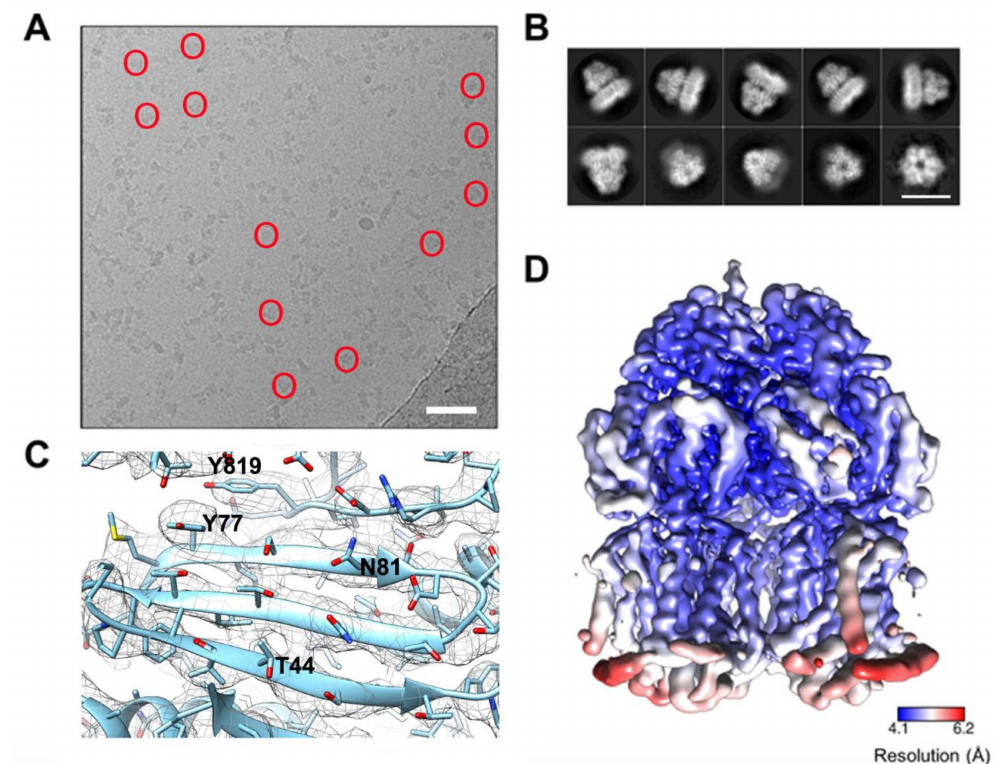
Figure 1. Single particle cryo-electron microscopy reconstruction of STmAcrB G288D processed in C3 space group. ( A ) Representative micrograph of S TmAcrB G288D collected on a K2 camera, with a scale bar in white representing 50 nm. Some representative STmAcrB G288D particles are circled in red. ( B ) Two-dimensional (2D) classes of S TmAcrB G288D, produced in RELION as seen from the side, high angle, and top views. The scale bar represents 15 nm. ( C ) Representative experimental electron map density processed in C3 space group (mesh), with the refined S TmAcrB G288D model fitted (cyan). Reference residues labelled within the map include, T44, Y77, N81 and Y819. ( D ) The C3 derived map from S TmAcrB G288D coloured by local resolution in Angstroms (Å) showing the core to be more highly resolved, while the transmembrane flanking regions display lower